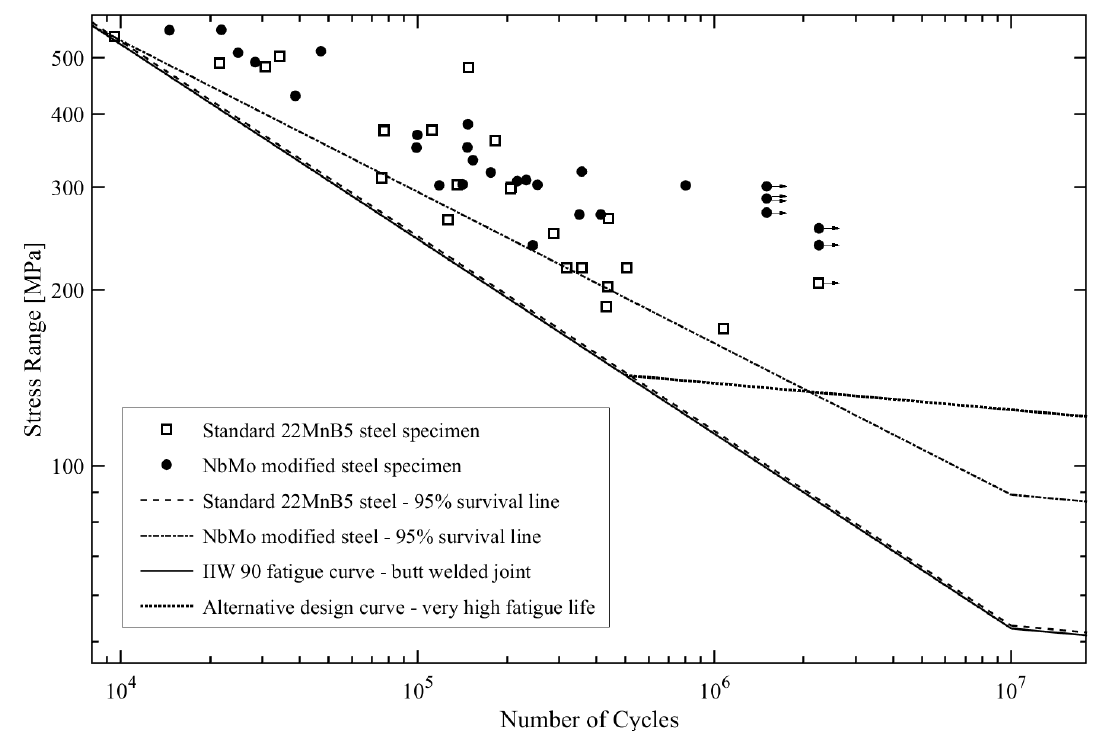
Figure 4. Comparison of S – N diagrams for the two laser-welded 22MnB5 steels.